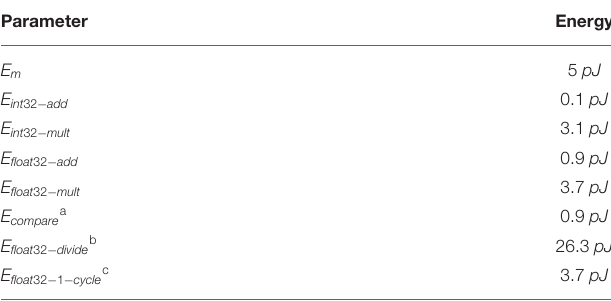
TABLE 3 | Energies assumed for the estimation of the power consumption.